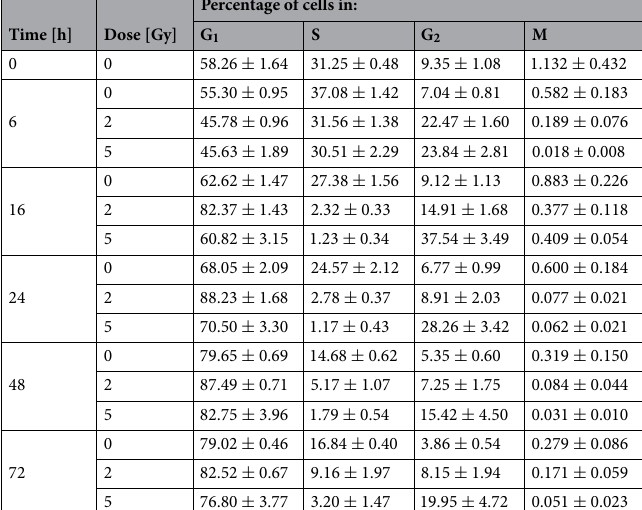
Percentage of cells in: G